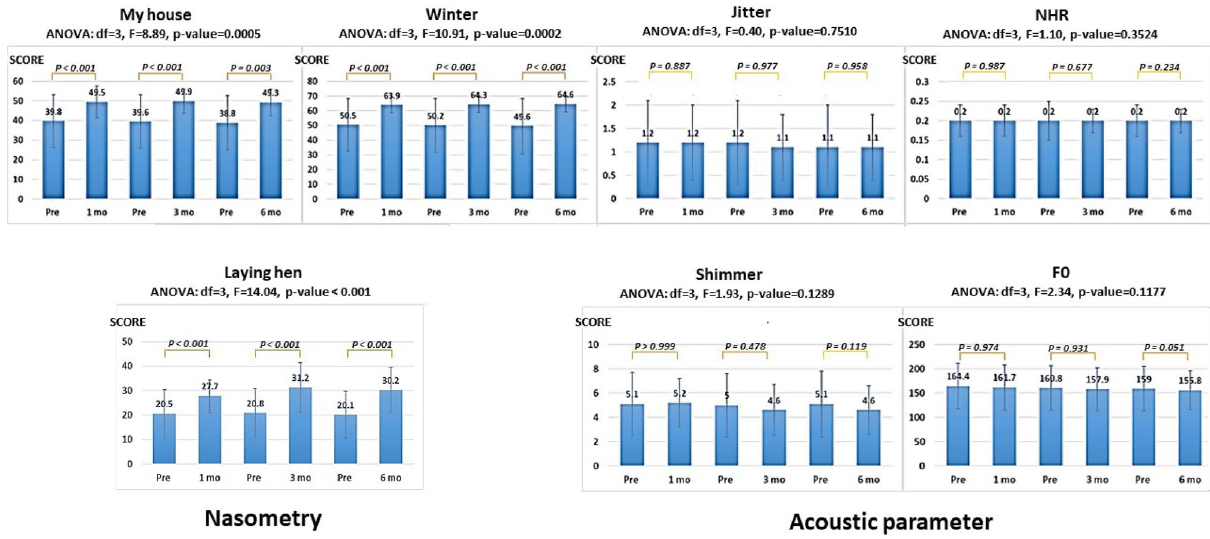
Figure 2. Objective measurement of voice included nasometry and acoustic parameters. All parameters of nasometry showed that the mean score between pre- and postsurgery was significantly different at 1, 3 and 6 months (p < 0.05); in contrast, all acoustic parameters showed no significant difference pre- and postsurgery at 1, 3 and 6 months (p > 0.05).